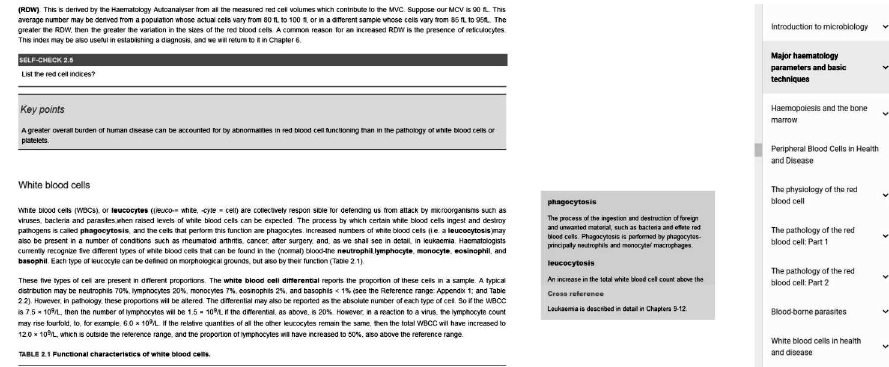
Figure 2. Digital textbook with links to related pages within the same